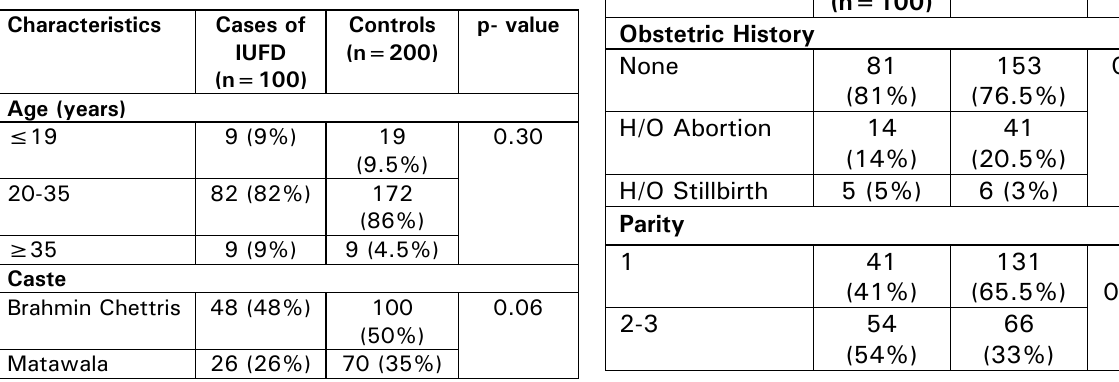
Table No 2: Demographic Characteristics of Mothers with Stillbirths and Controls Characteristics